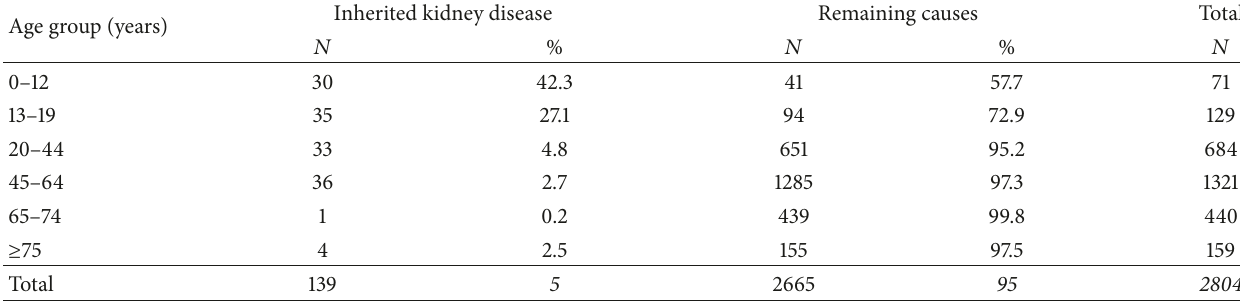
Table 2: Distribution of inherited kidney disease by age in ESKD patients (2001–2015).